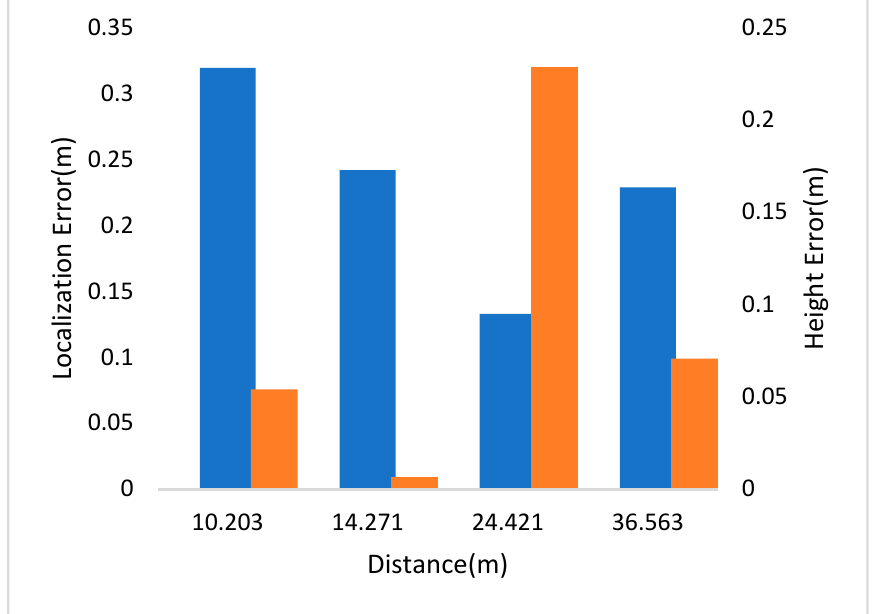
Figure 4. Localization and height error of Scene 1 in CUMTB-Campus. 2. Scene 2: Scene 2 was an outdoor scene on the main road besides the library of the CUMTB. The image with 8.3 megapixel resolution was taken by GeoSLAM-ZEB-HORIZON scanner on 22 October 2019. The scanner also acquired LiDAR point clouds along the same road. There are more people in this scene, and they are in different positions including people overlapping. There are also several pedestrians on the steps. As shown in Figure 5, the YOLO algorithm was used to obtain the pixel coordinates for each pedestrian detection box.